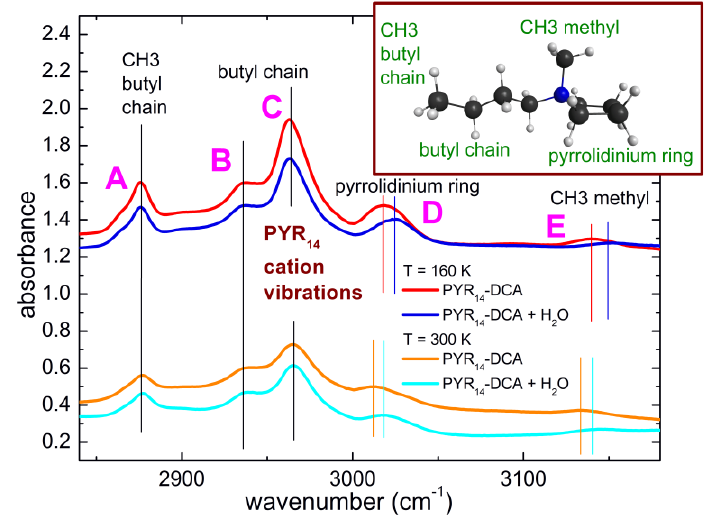
Figure 9. Comparison of the infrared absorption spectra measured at 160 K and 300 K of PYR 14 -DCA and PYR 14 -DCA + H 2 O in correspondence with the CH stretching vibrational bands. The curves are vertically shifted for clarity.